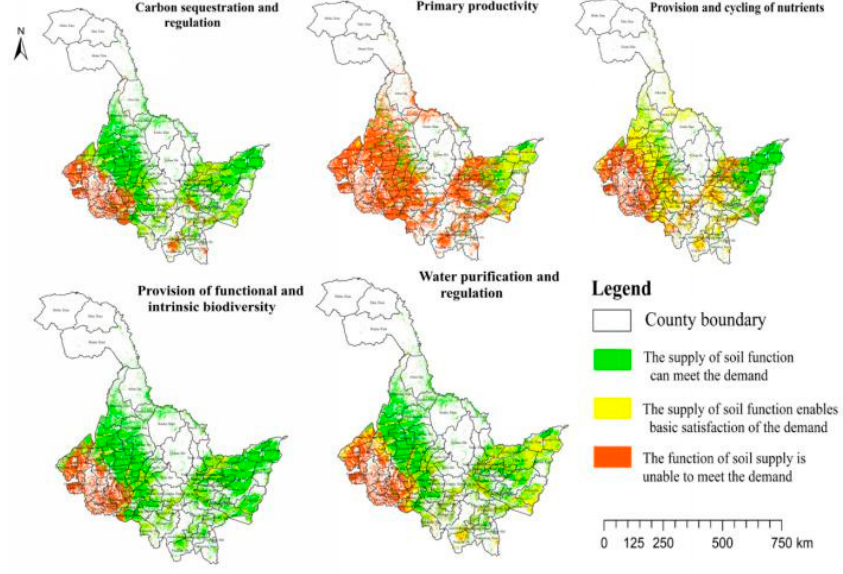
Figure 12. Distribution map of supply ‐ demand ratio of cultivated land soil function.